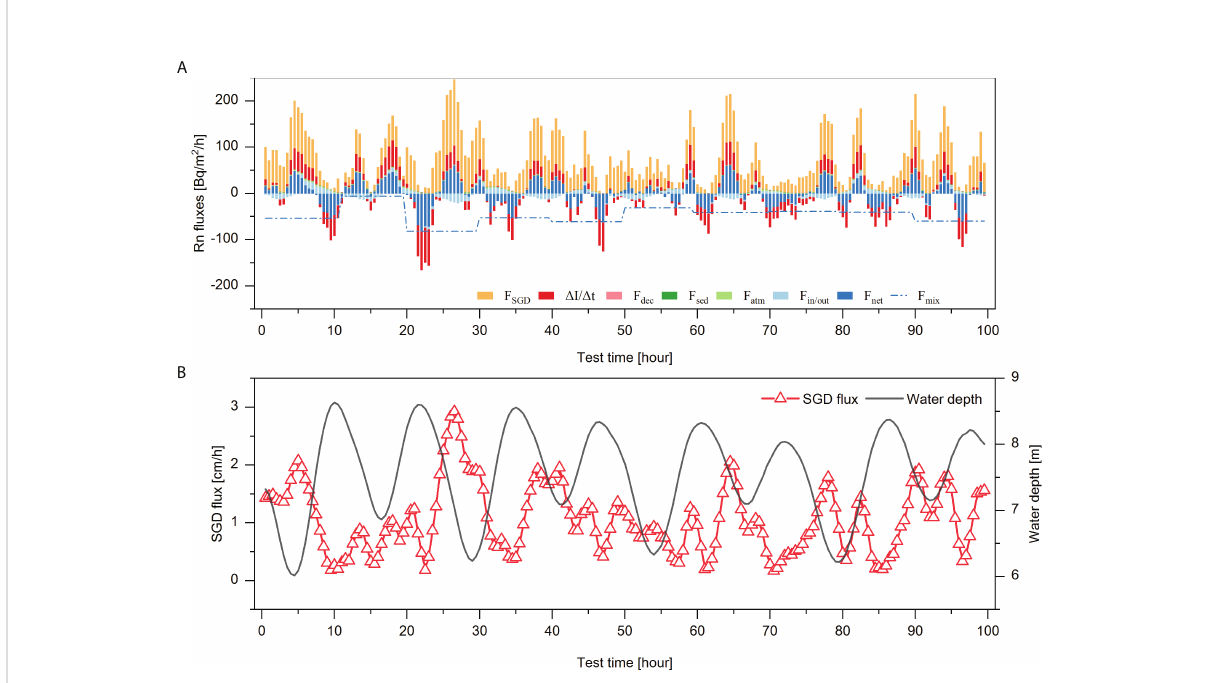
FIGURE 6 (A) Radon fl uxes of the sources (SGD, 222 Rn diffusion from bottom sediments, dissolved 226 Ra decay, and input of incoming seawater during fl ood tides) and sinks (outgoing water during ebb tides, and atmospheric evasion) in the Jiaozhou Bay during the long-time series measurements. The blue dashed line represents the conservative mixing loss fl uxes. (B) Temporal variations of SGD fl ux versus tidal depth during continuous radon